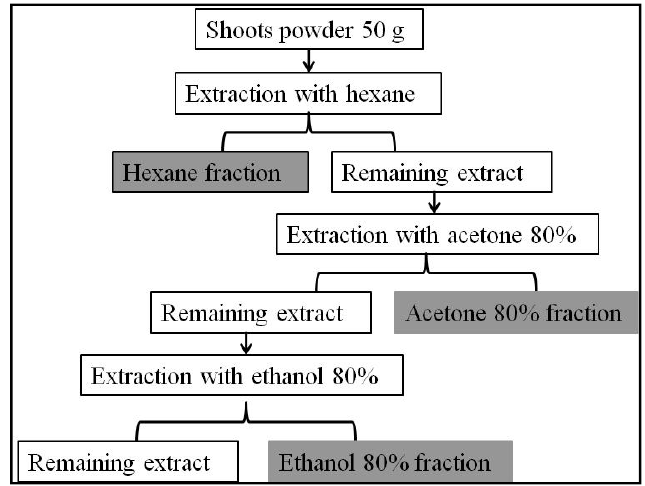
Figure 3. Extraction procedure of A. indicum shoots.